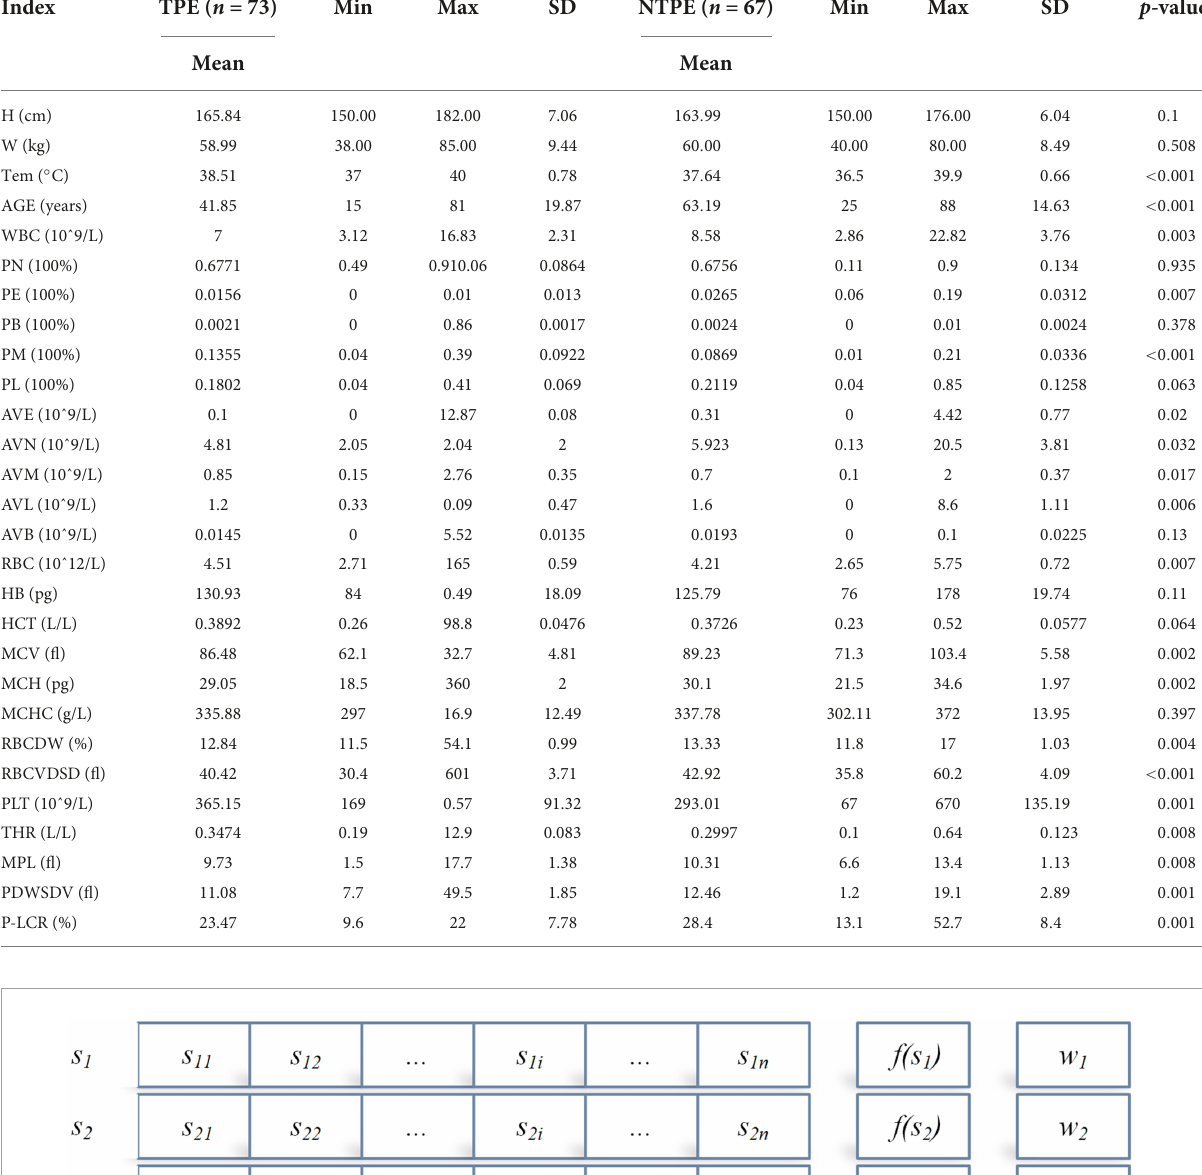
TABLE 4 Biochemical and clinical parameters in TPE patient and Non-TPE patient.